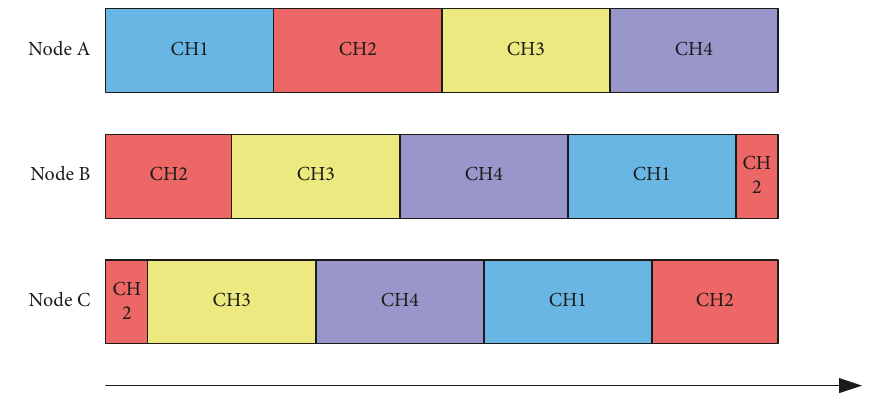
Figure 3: An example unicast FH